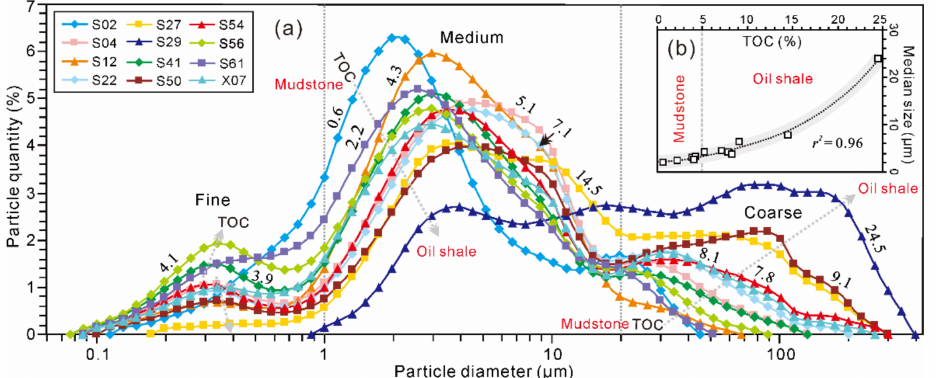
Figure 4. The distribution of laser particle sizes for pulverized samples from boreholes Ngn2 and ZK3389 ( a ), and the relationship between TOC contents and median sizes ( b